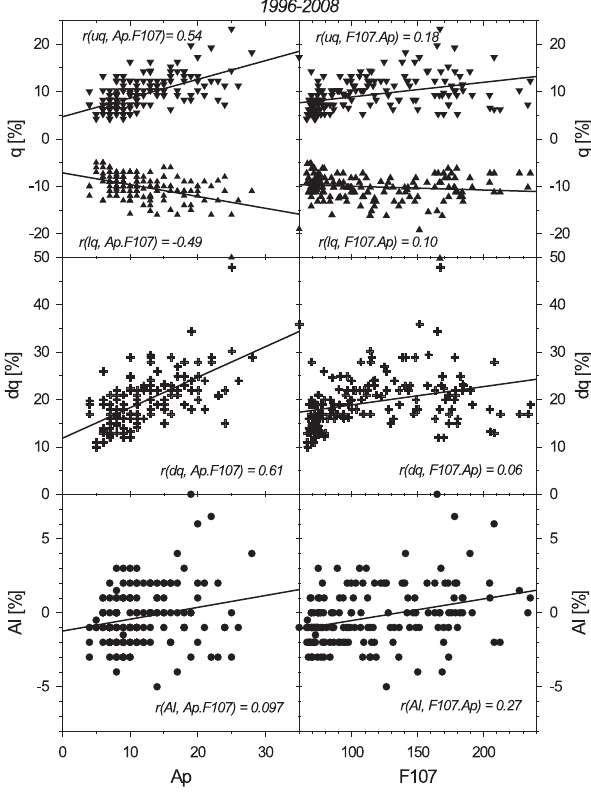
Fig. 12. Dependence of monthly upper quartile uq, lower quartile lq, quartile difference dq, and AI median values on geomagnetic activity (left part) and on solar activity (right part). The black lines are simple regression lines whereas the included values are partial correlation